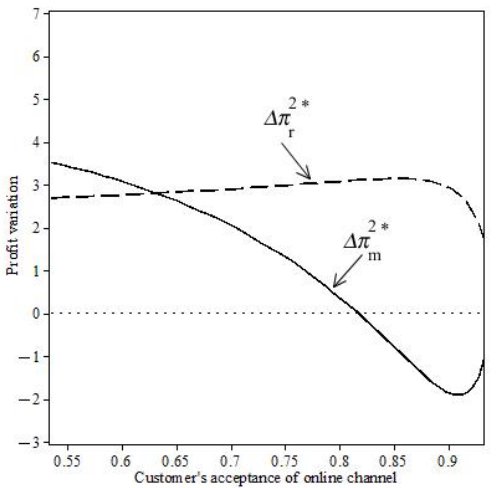
Figure 2. The impact of θ on the profit variation under Mechanism 2.